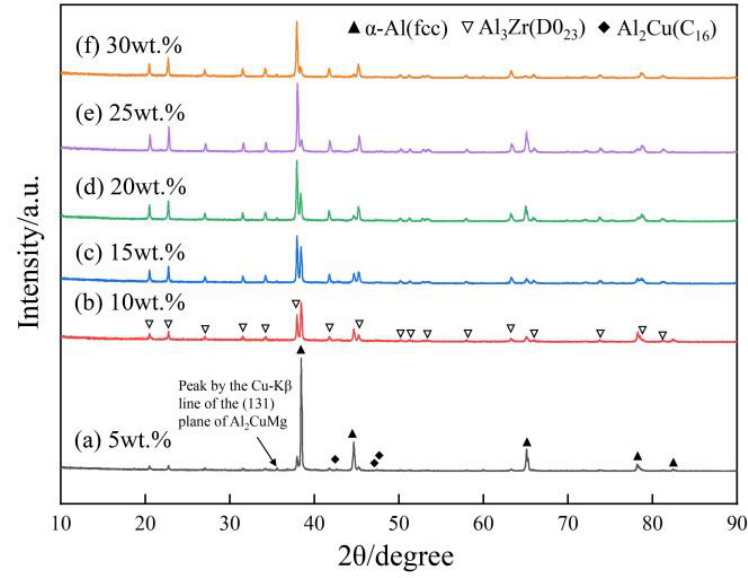
Figure 3. XRD patterns of the composites with different Zr contents.